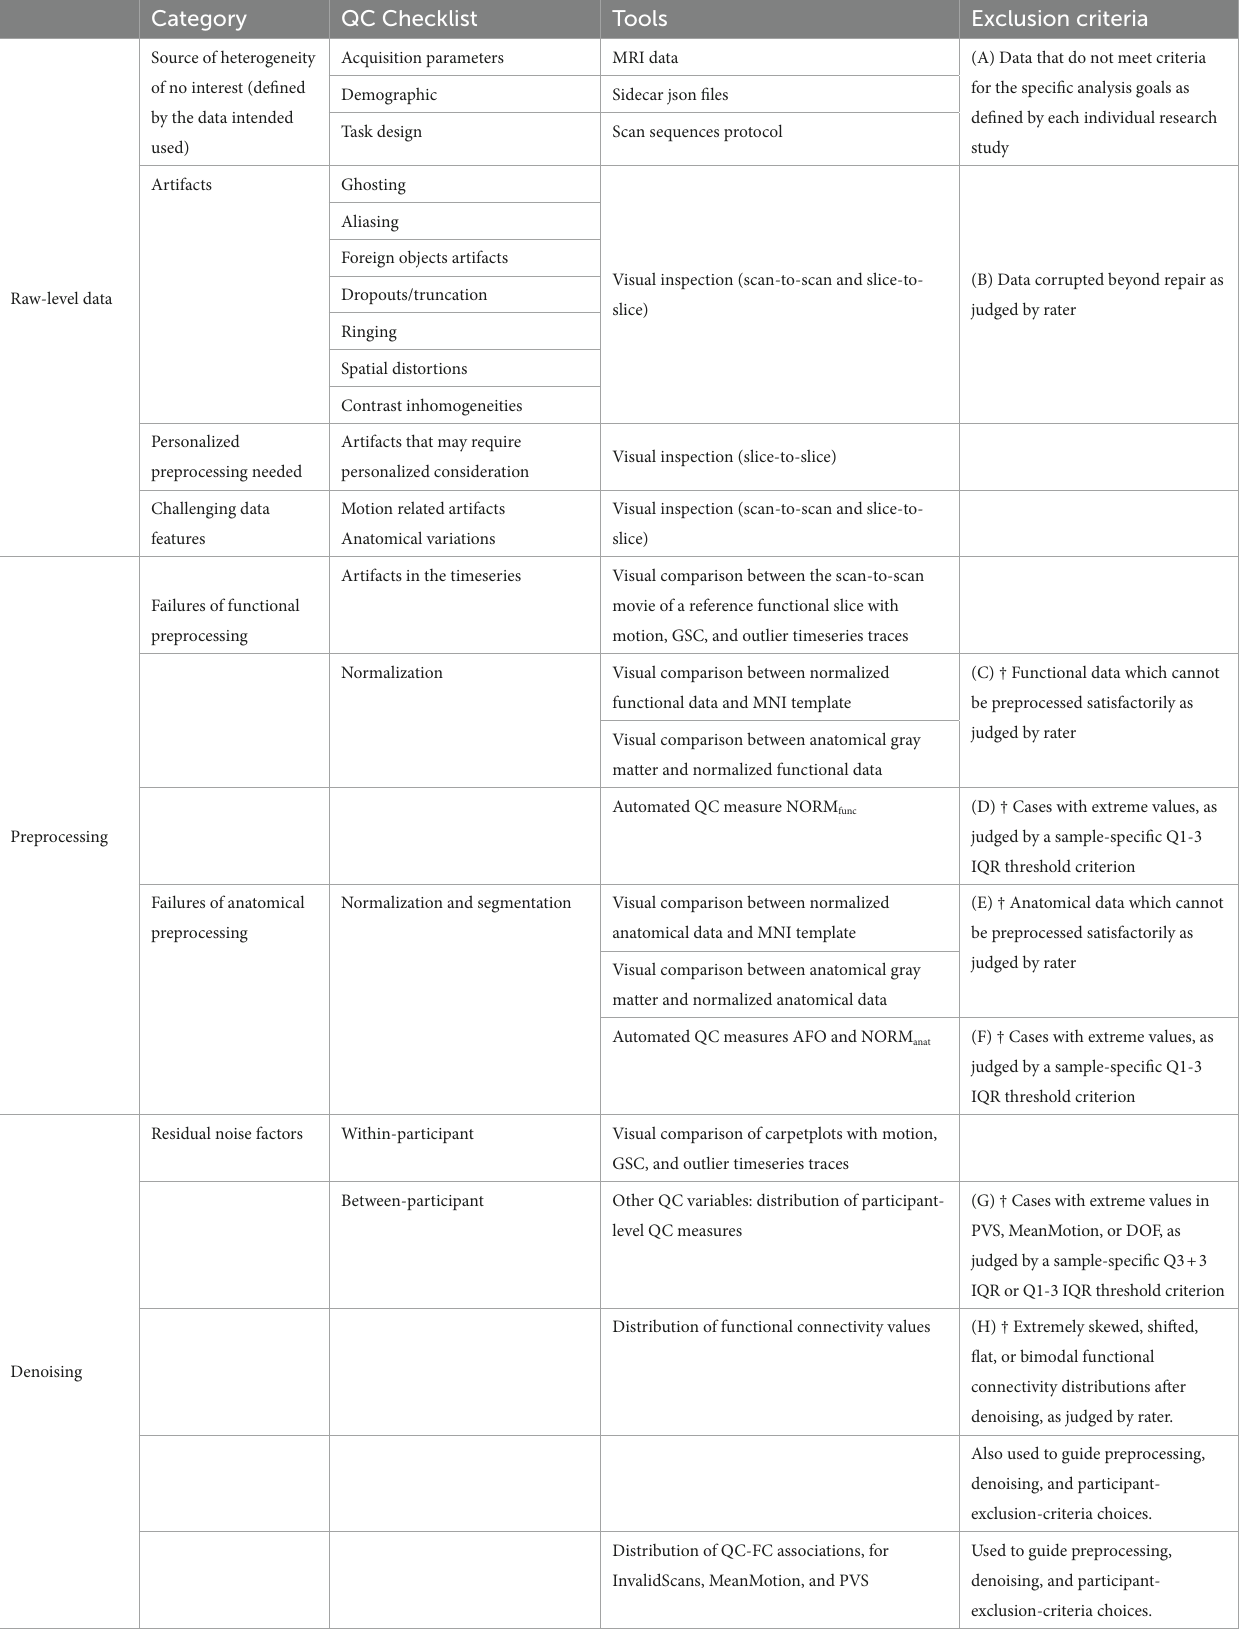
TABLE 4 CONN quality control pipeline checklist and exclusion criteria for whole brain resting state functional connectivity